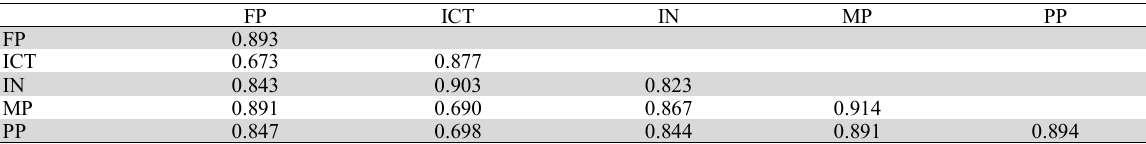
Discriminant Validity